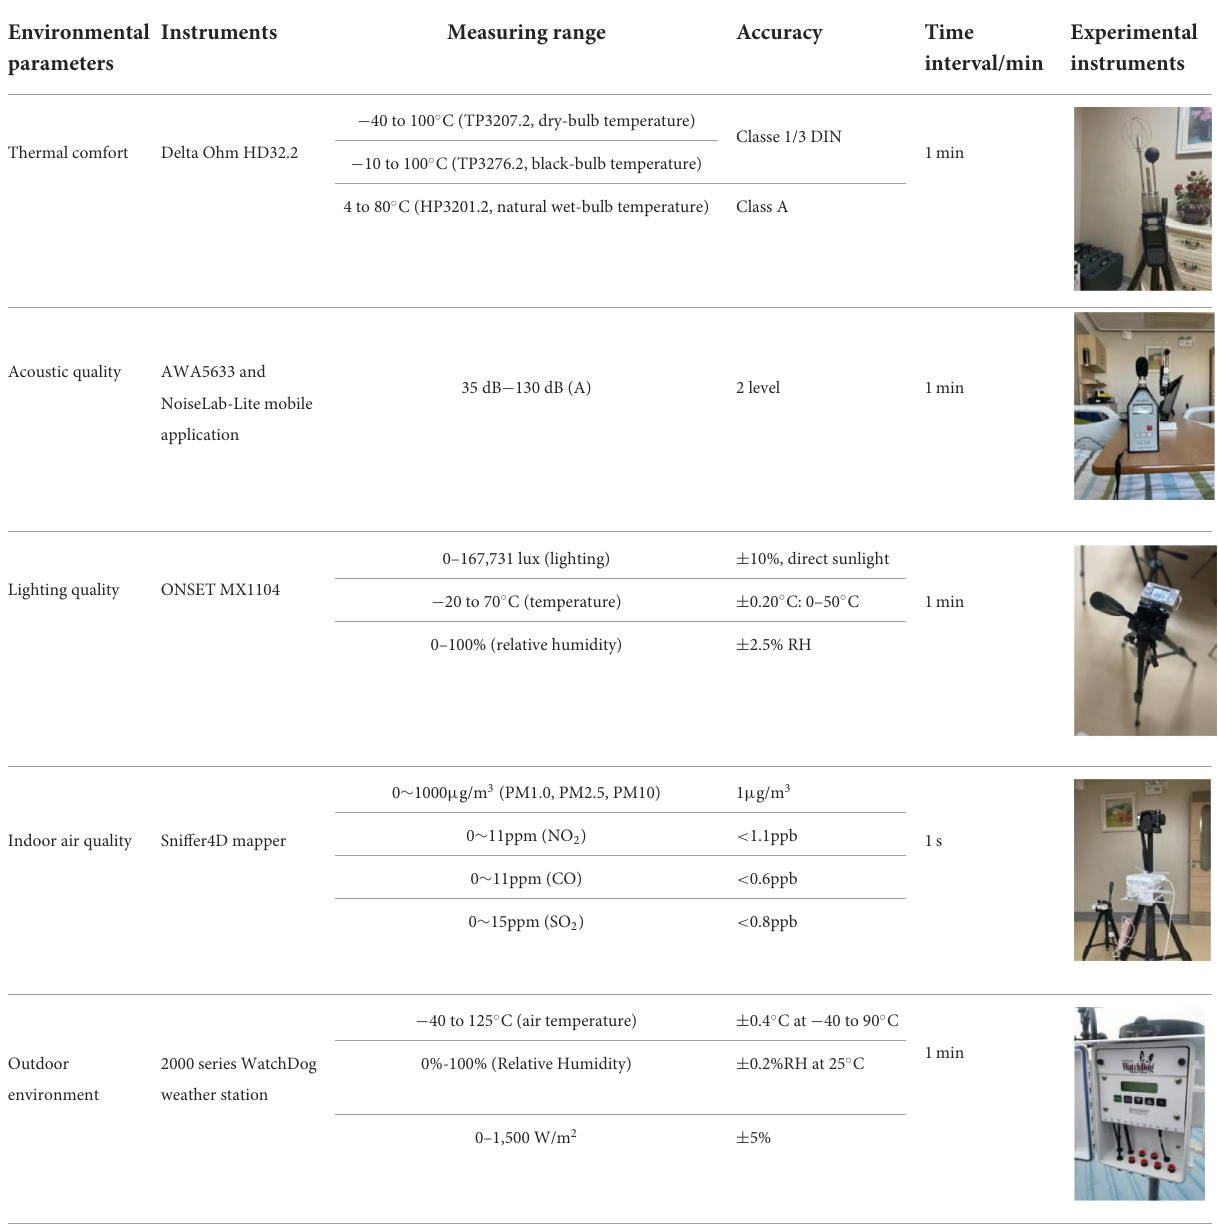
TABLE 2 Basic characteristics of the experimental